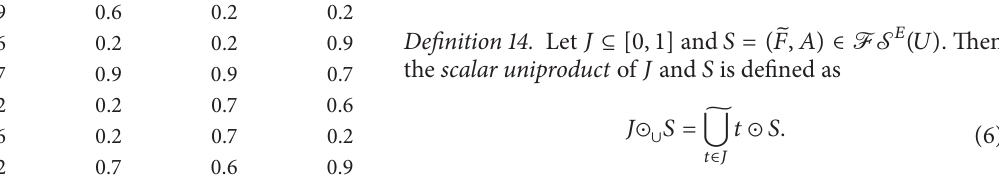
Table 1: Tabular representation of the fuzzy soft set S =